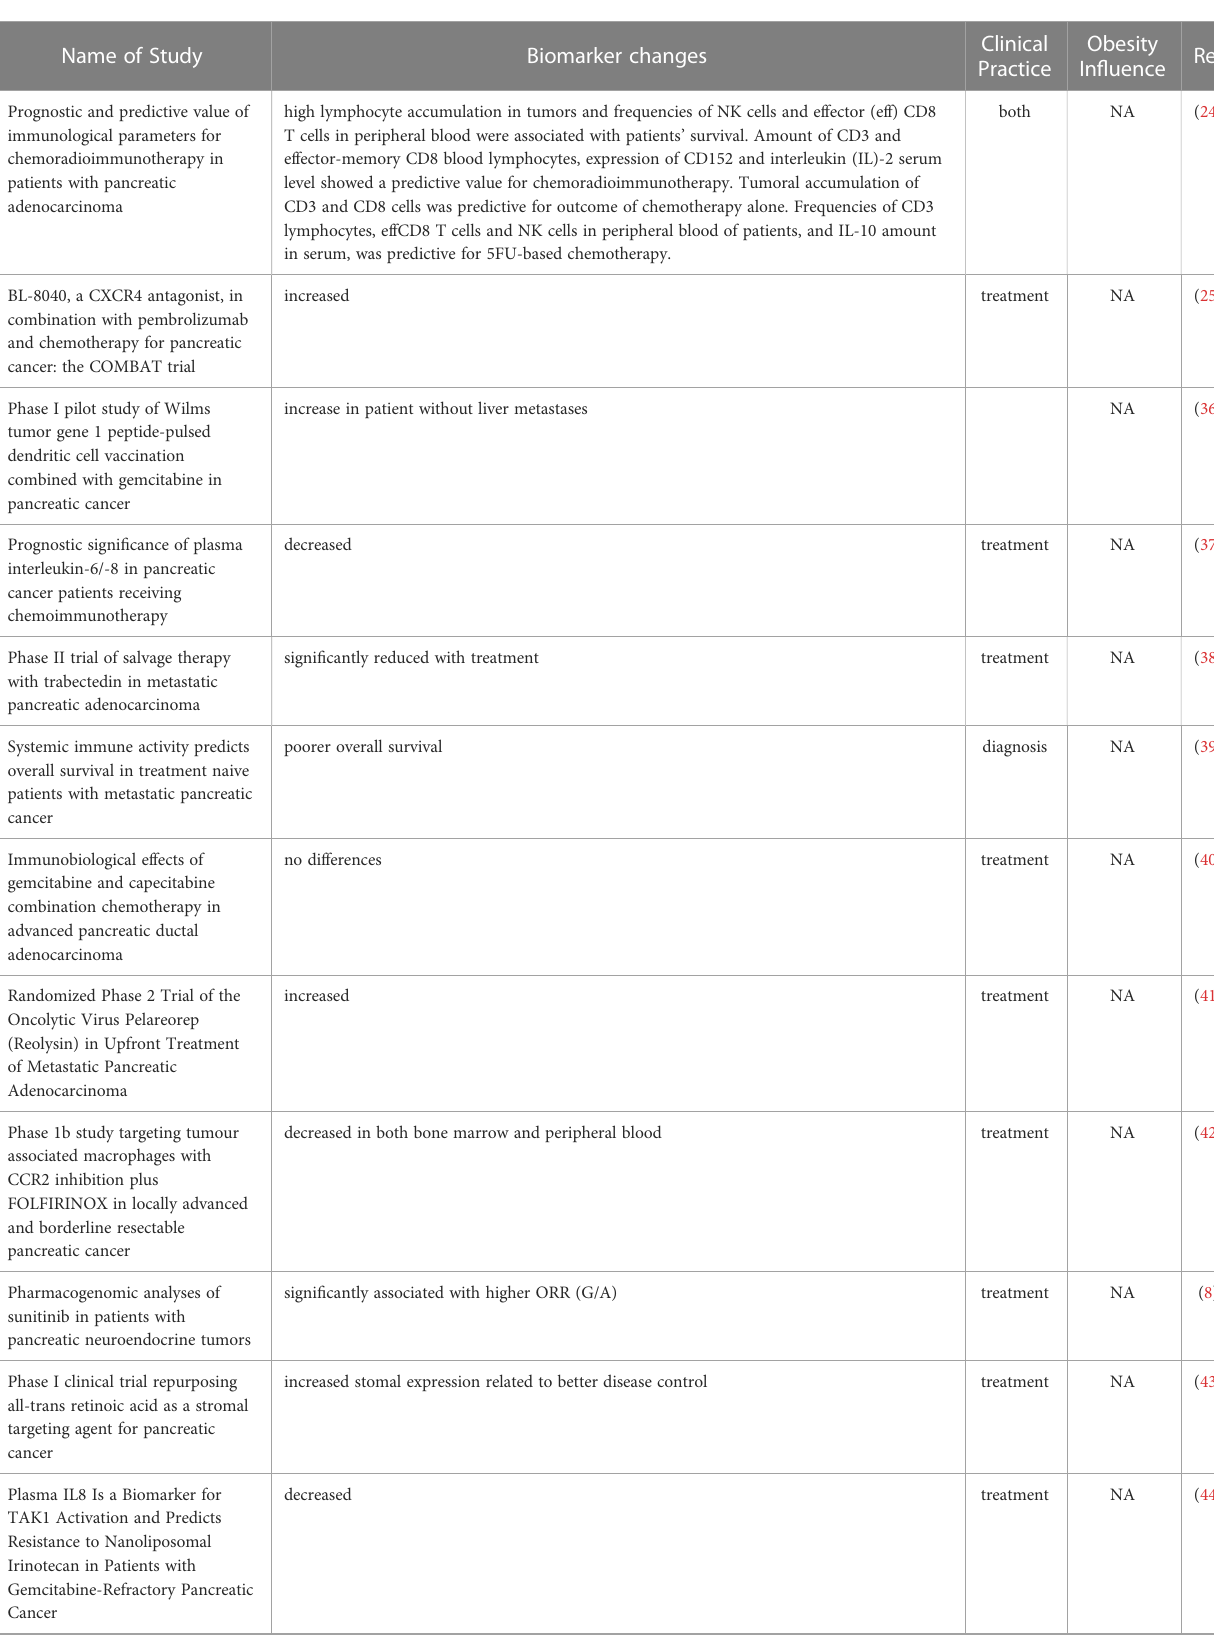
TABLE 4 Biomarker changes speci fi c to pancreatic